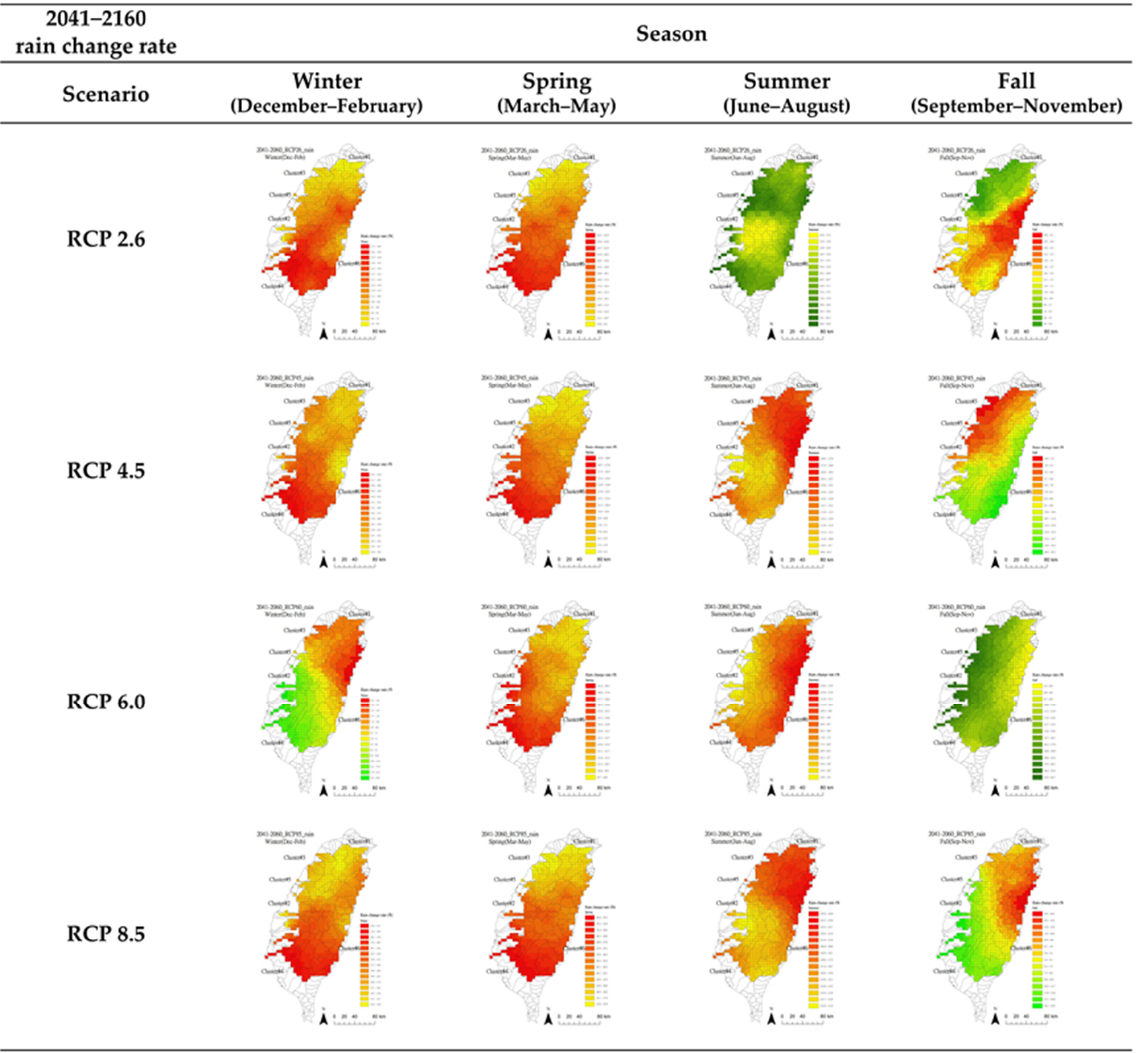
Figure A6. Spatial distribution of rain change rate from 2041–2060 for four seasons under different climate change scenar- ios.